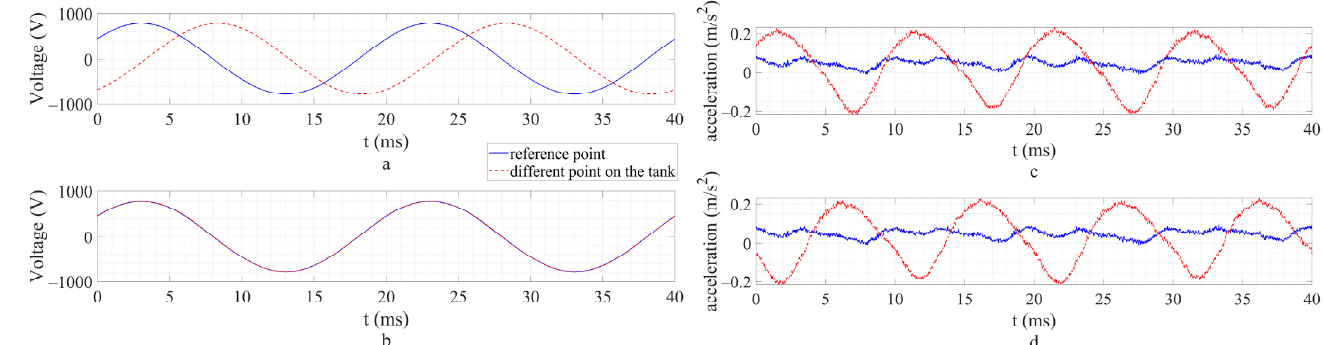
Figure 3. Single-sided amplitude spectrum of Signal to Noise Ratio for point 75 at the surface 5 of the transformer.